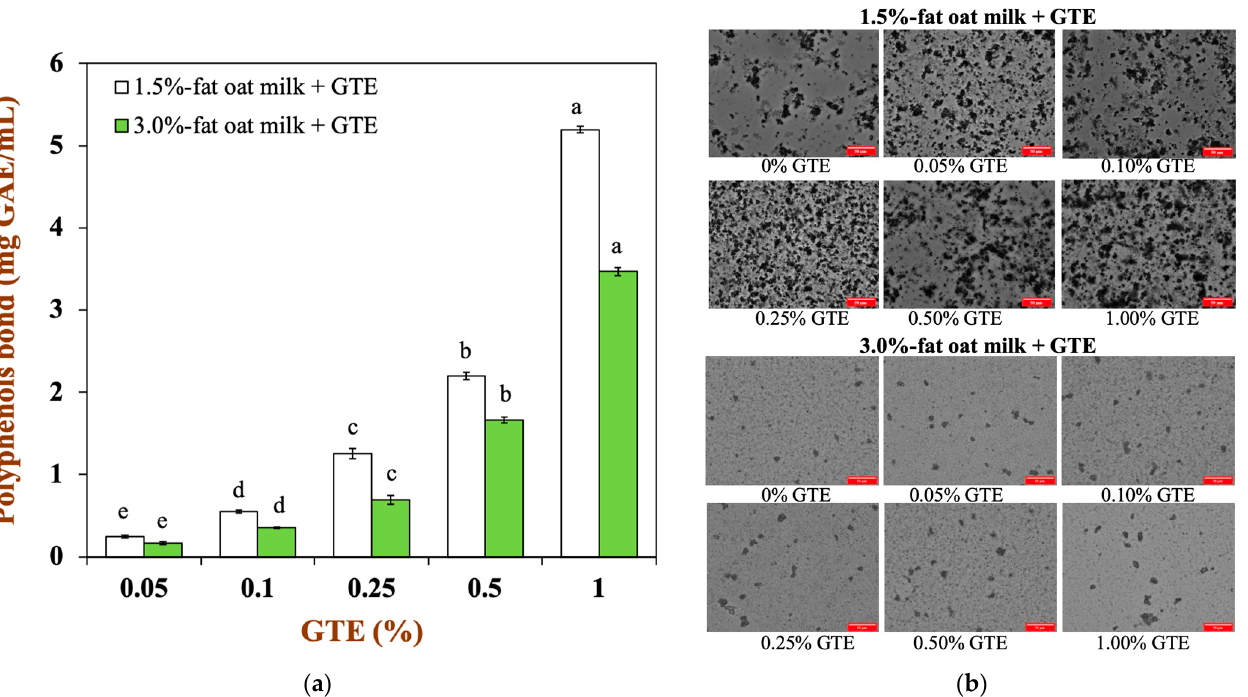
Figure 1. ( a ) The binding capacity of tea polyphenols with the two types of oat milk: ( b ) the microstructure of oat milk tea model system with two fat levels (scale label = 50 µm). Samples with different lowercase le tt ers indicate signi fi cant di ff erences ( p < 0.05) when compared to various concentrations of green tea extract .